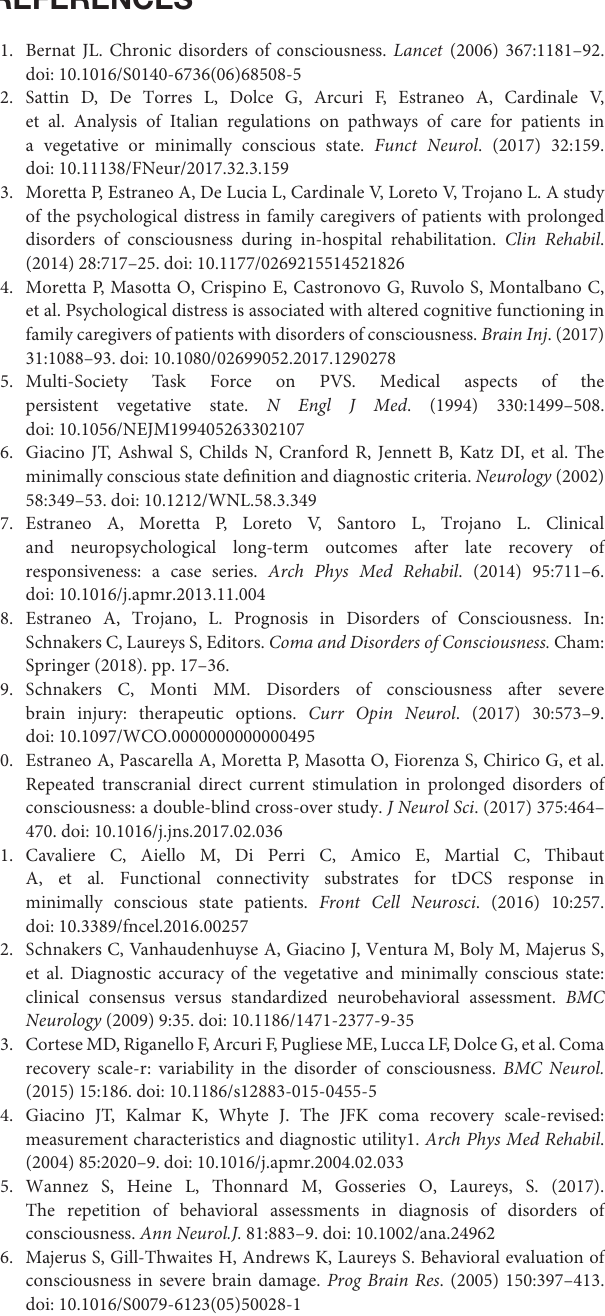
Figure S5 | Distribution plots of GS for the best acquisition, concatenated data and FDG-PET for patients in EMCS, MCS and UWS. Table S1 | Coma Recovery Scale-Revised total and subscores in the three patients collected in the day of neuroimaging and 5 days in 1 week before and